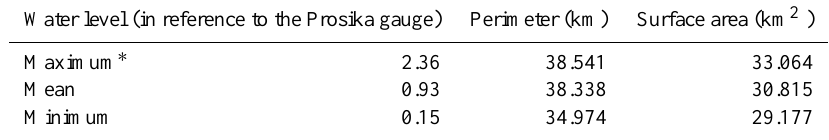
Table 7. Percentage of flooded habitats at the water level of 2m in reference to the Prosika gauge. NKS_DESCRIPTION Flooded area Total area of the Percentage Complex mosaic of crops Illyrian-sub-Mediterranean river valley meadows/ Mediterranean halophytic Juncus species Mixed evergreen forests and holm oak maquis Brambles Shore uncovered or rarely covered by vegetation Illyrian-sub-Mediterranean river valley meadows Tree lines at the edges of cultivated areas Brambles/thermophile flooded underbrush Thermophile flooded underbrush Aleppo pine plantations Tyrrhenian–Adriatic limestone Consolidated arable land with monoculture crops (cereals) Man-made or industrial